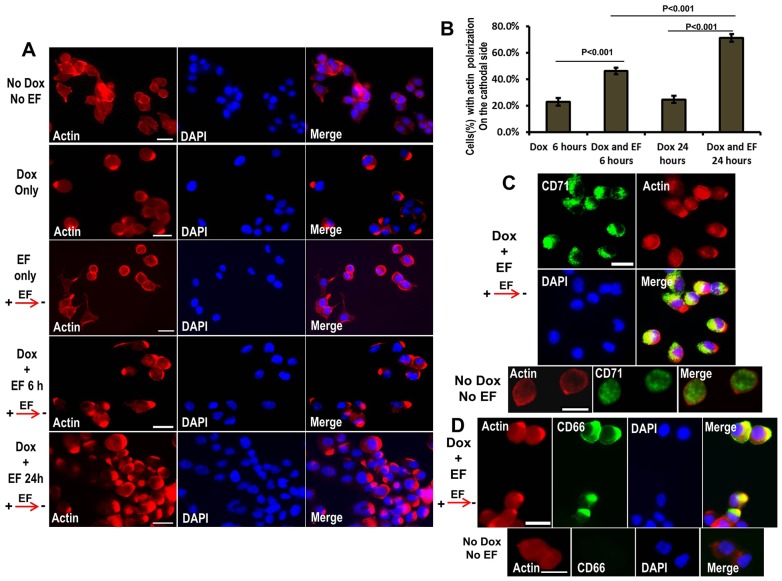
Electrical signals polarize actin, CD66 and CD71 in enterocytes. (A) Cells were stained with phalloidin (F-actin label indicative of apical membrane) in control cells, and cells treated with Dox only, electric field (EF) only, Dox+electric field groups. Electric field direction is shown with red arrows. Electric field stimulation causes a polarization of F-actin on the cathodal side of the cells (shown at the right). (B) Quantitative analysis of LS174T-W4 cells with actin polarization facing the cathode in an applied electric field. Analysis methods are shown in supplementary material Fig. S3. Values are mean±s.e.m. for three experiments. (C) Upper two rows: LS174T-W4 cells were treated with electric field and Dox for 24 hours. Polarized actin labeling faced the cathode, and the basal membrane marker CD71 was localized selectively at the anode side. The lower row are control cells, which show no actin or CD71 polarization. (D) Upper row: CD66 staining, as an apical marker, showing an overlapping distribution with cathodal actin polarization in LS174T-W4 cells in applied electric field plus Dox. Lower row: there is no actin and CD66 polarization in no Dox plus no electric field control cells. The applied electric field was 100–200 mV/mm. Scale bars: 10 µm.